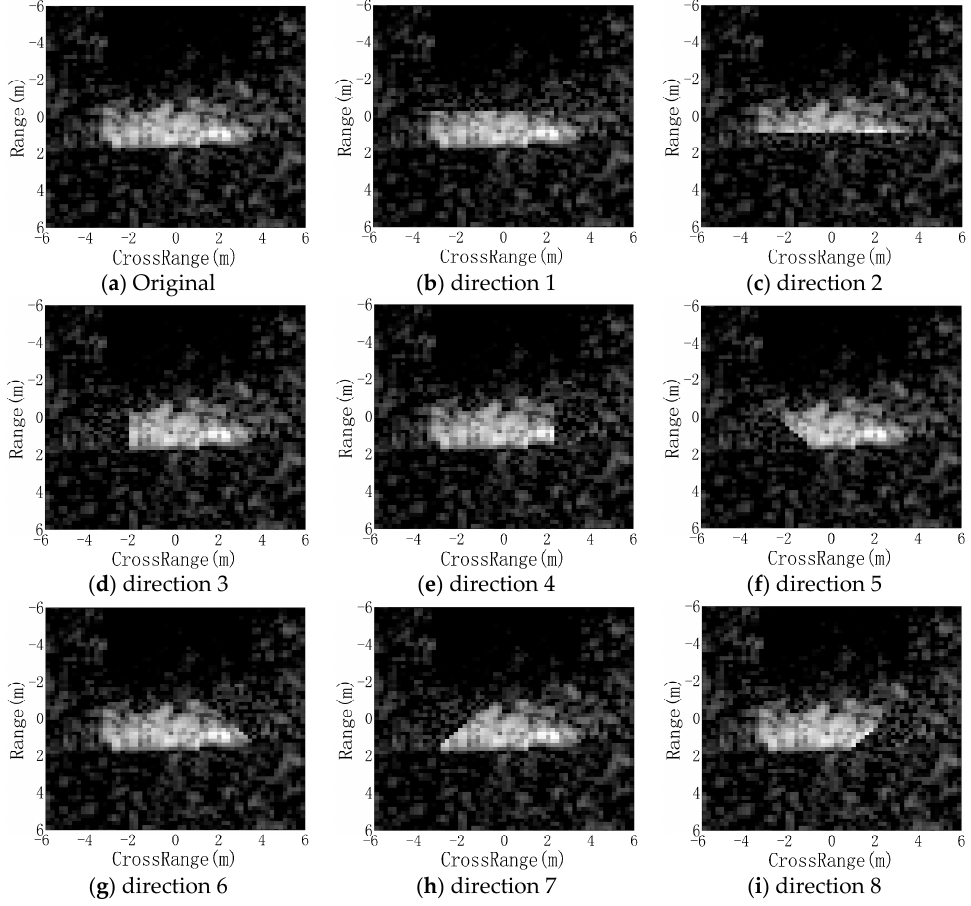
Figure 10. Twenty percent (20%) occluded images from eight directions.